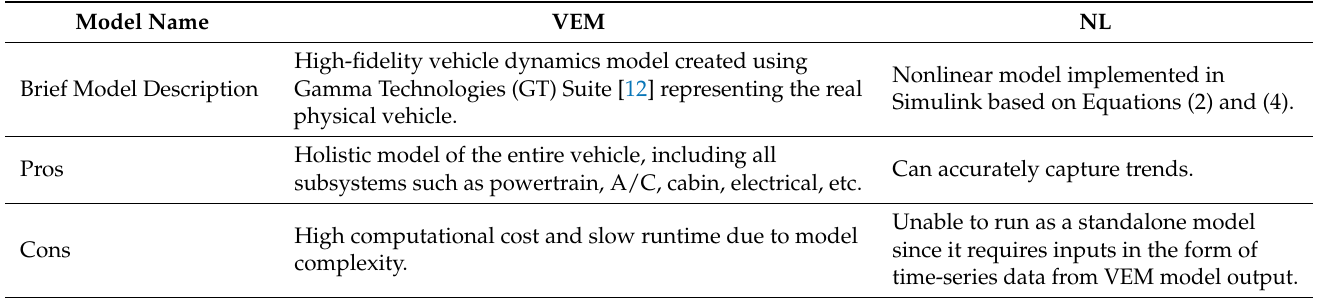
Table 1. Model summary and